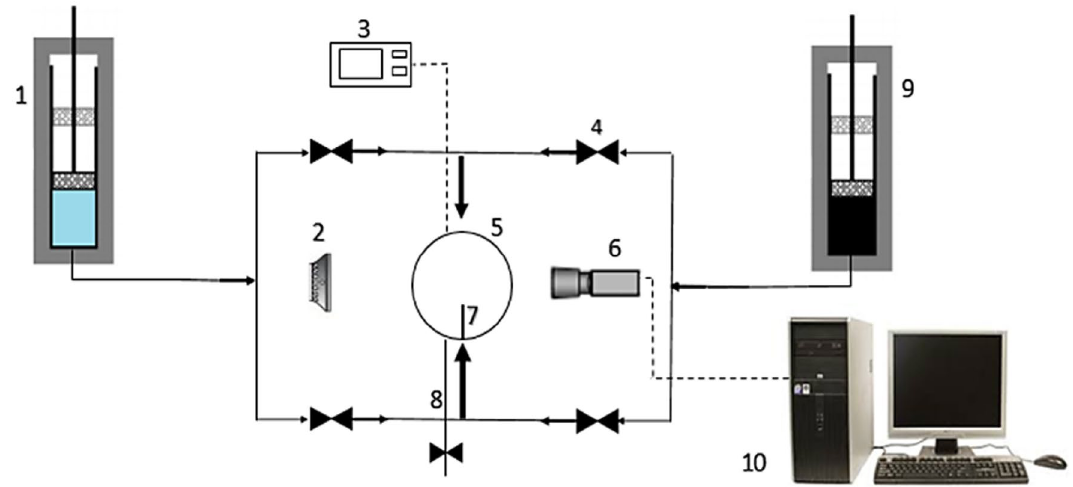
Fig. 1 Schematic diagram of the IFT400; 1: bulk flow pump, 2: adjustable light source, 3: indicator and temperature and pressure controller, 4: high-pressure valve, 5: cell, 6: camera, 7: drop needle,